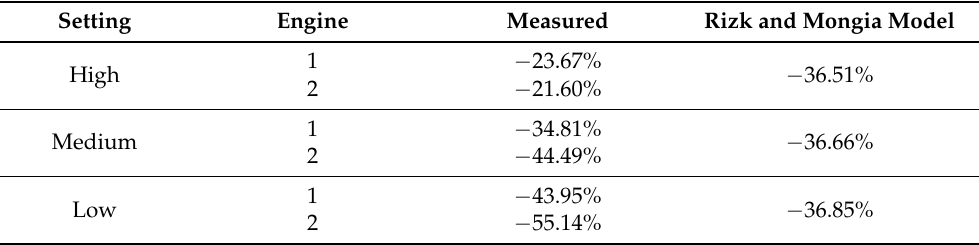
Table 2. Measured RDs in particle emissions from flight tests [1] between a 50:50 HEFA C. blend and a medium-sulfur Jet A fuel, and RDs predicted with the Rizk and Mongia model [17], for different thrust settings.